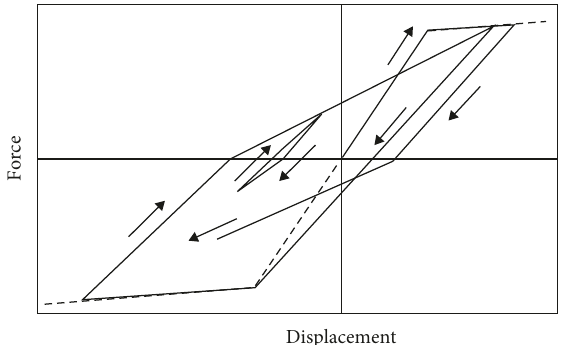
Figure 6: Force-displacement relationship defining the modified Takeda hysteretic model.